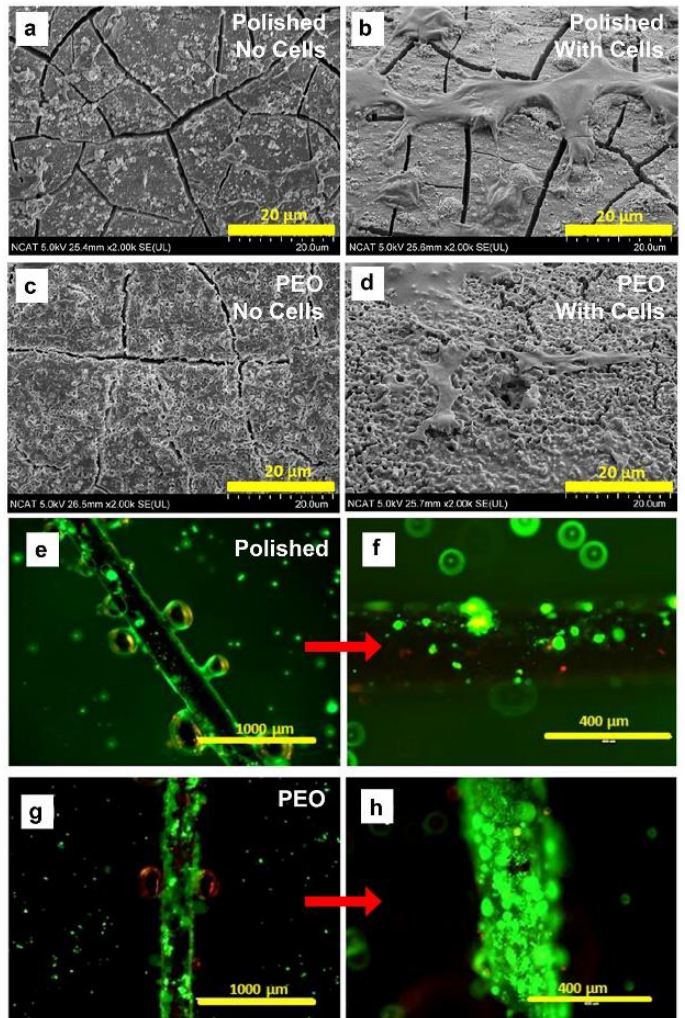
Figure 5. SEM imaging of the surface of Pol and PEO filaments after 12 h incubation in growth medium without ( a , c ) and with ( b , d ) PTBE cells added. A Live/Dead cell assay (live cells are green, red are dead) and light microscopy imaging showed that fewer viable cells attached to the Pol uncoated filaments ( e ) and higher magnification in ( f ) than to PEO coated filaments ( g and higher magnification in ( h ). With copyright permission from [35].